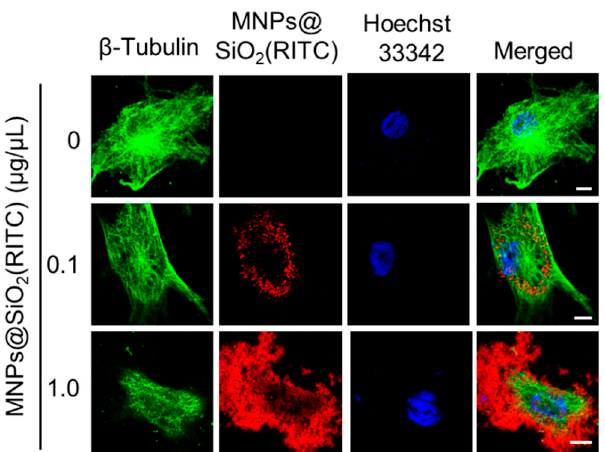
Figure 3. Tubulin-based analysis of the cytoskeleton of hBM-MSCs treated with MNPs@SiO 2 (RITC) for 12 h. β -Tubulin stained images of hBM-MSCs treated with MNPs@SiO 2 (RITC). Blue, Hoechst 33342; Green, β -tubulin; red, MNPs@SiO 2 (RITC). Scale bar = 10 μ m.